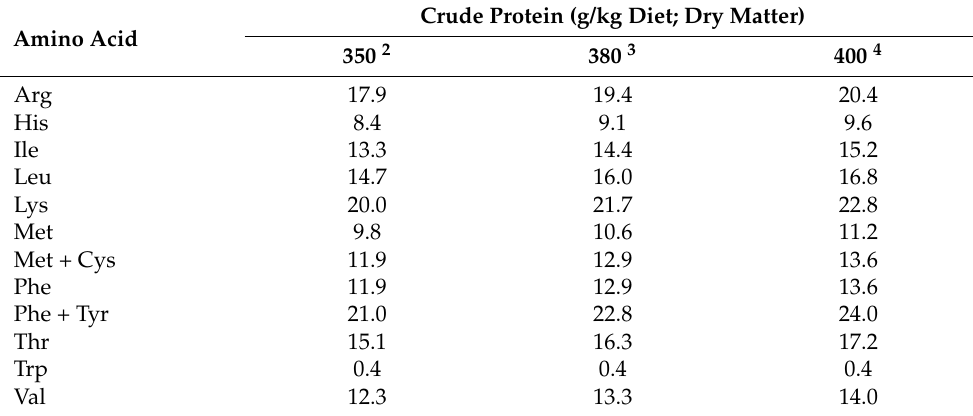
Table 4. Dietary amino acid recommendations (g/kg diet) for broodstock Nile tilapia 1